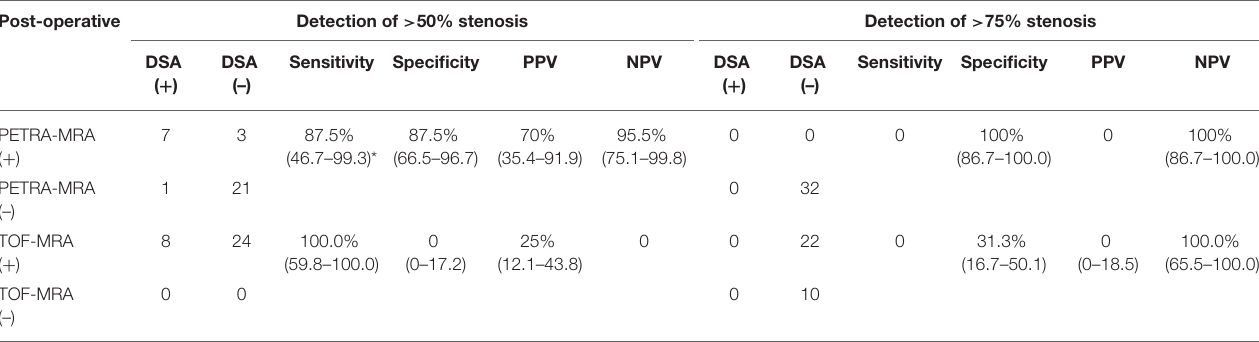
TABLE 3 | Evaluation of the diagnostic performance of PETRA-MRA and TOF-MRA for detecting stenosis > 50% and stenosis > 75% using DSA as a reference of the post-intervention.